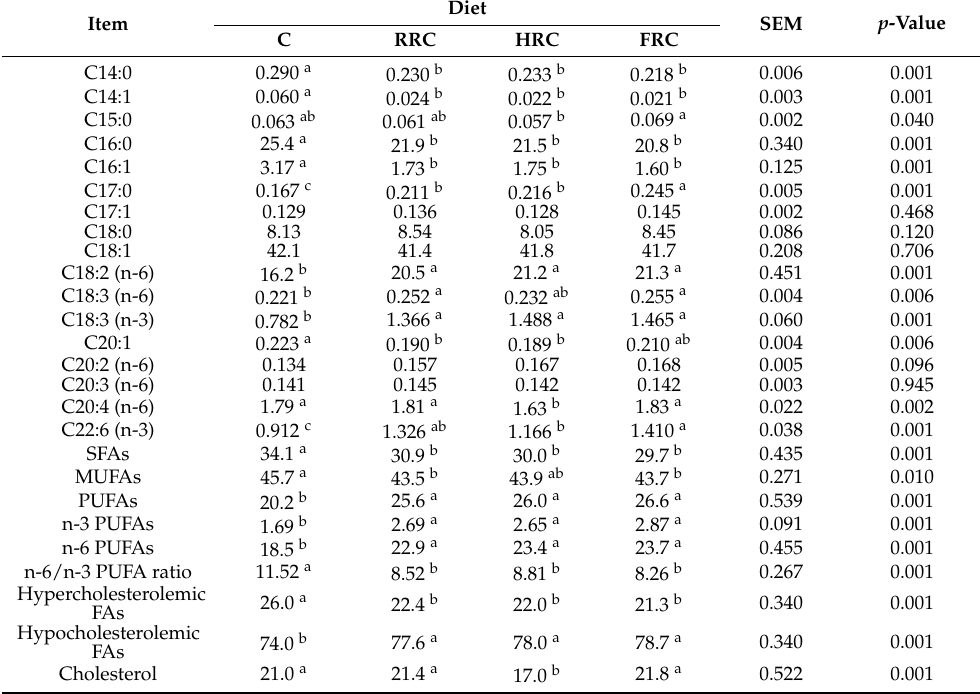
Table 5. Effect of raw (RRC), hydrobarothermally-treated (HRC) and fermented (FRC) rapeseed cake on the fatty acid composition (% of total fatty acid content) and cholesterol content of yolk lipids (%) 1